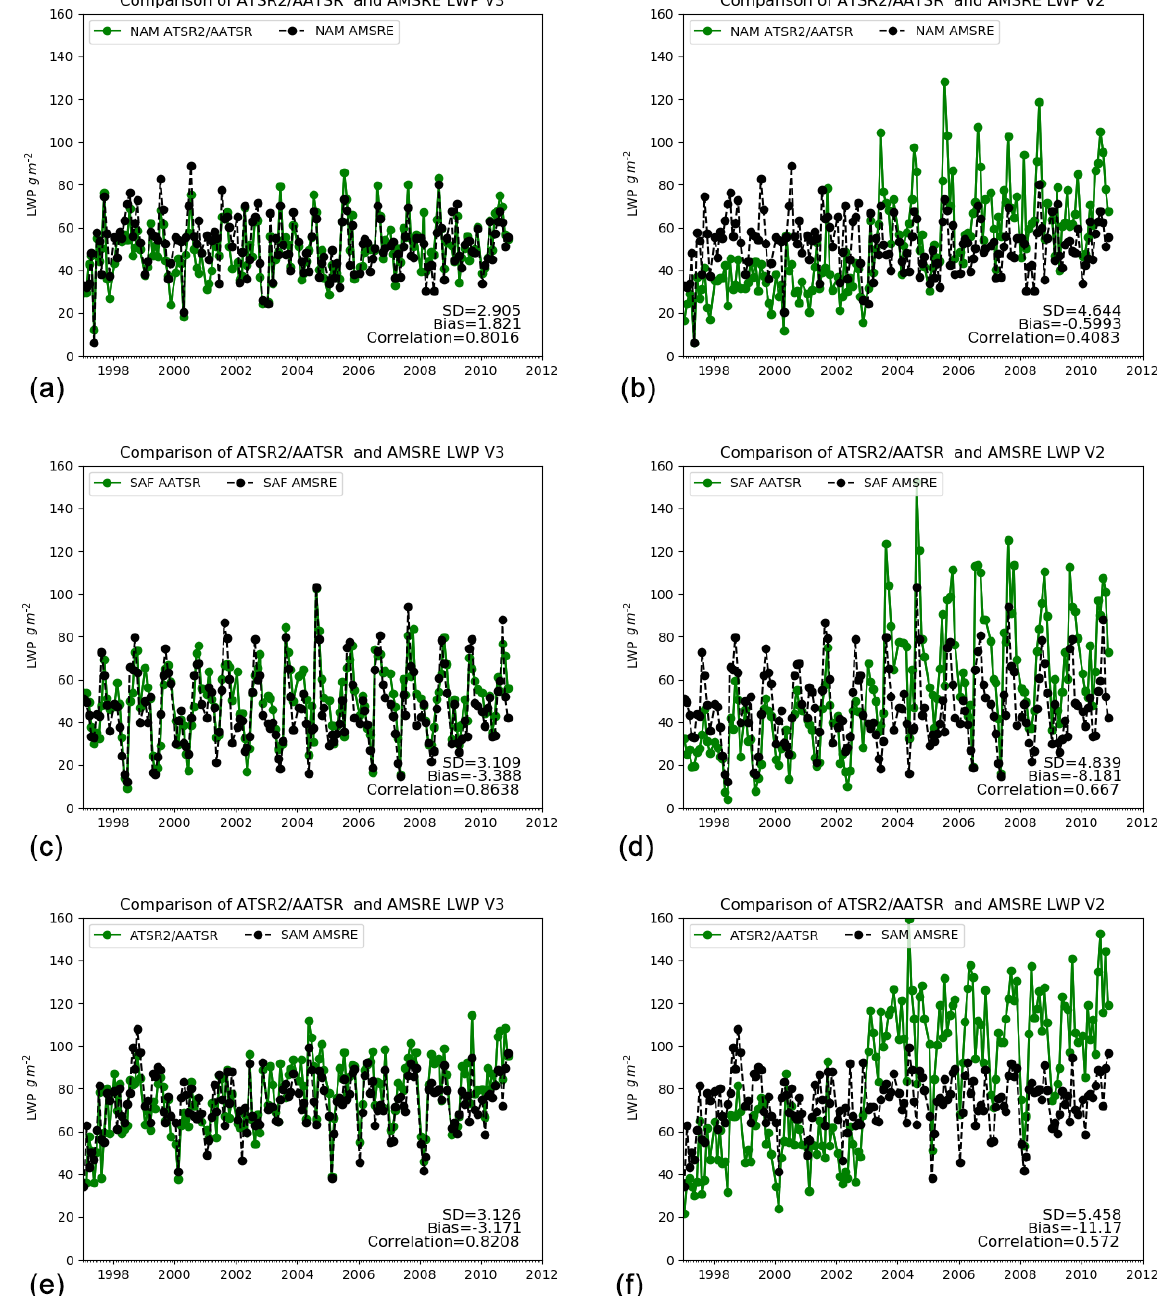
Figure 3. Comparison of ATSR-2/AATSR Cloud_cci LWP time series (coloured) with MAC-LWP (black) for three regions: west of Cal- ifornia (NAM, a, b ), west of Africa (SAF, c, d ), and west of South America (SAM, e, f ). Version 3 (a, c, e) has reduced the discontinuity between sensors seen in version 2 (b, d, f)